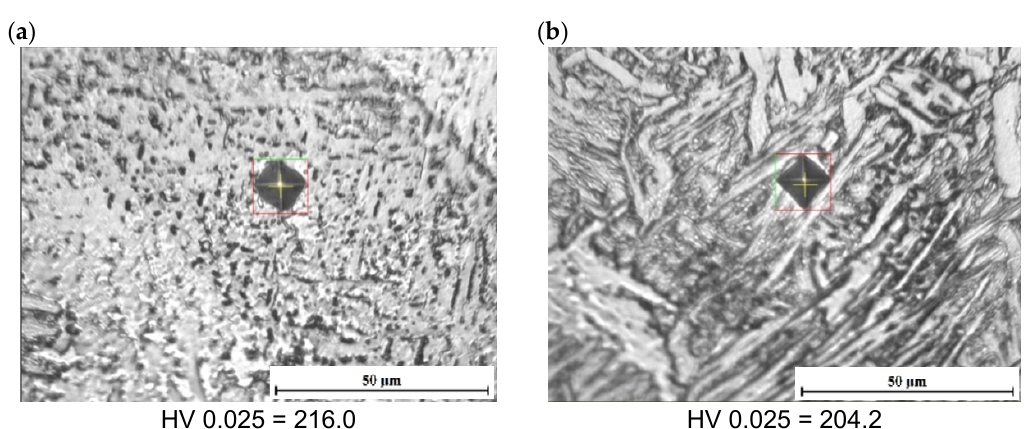
Figure 6. Austenite decomposition kinetics in terms of relative change in length during cooling of alloys A, B and C according to schedule I. The marked temperatures on the curves of alloys A and B designate the A r1 and A r3 temperatures and on the curve of alloy C designate the martensite start (M S ) and martensite finish (M f ).